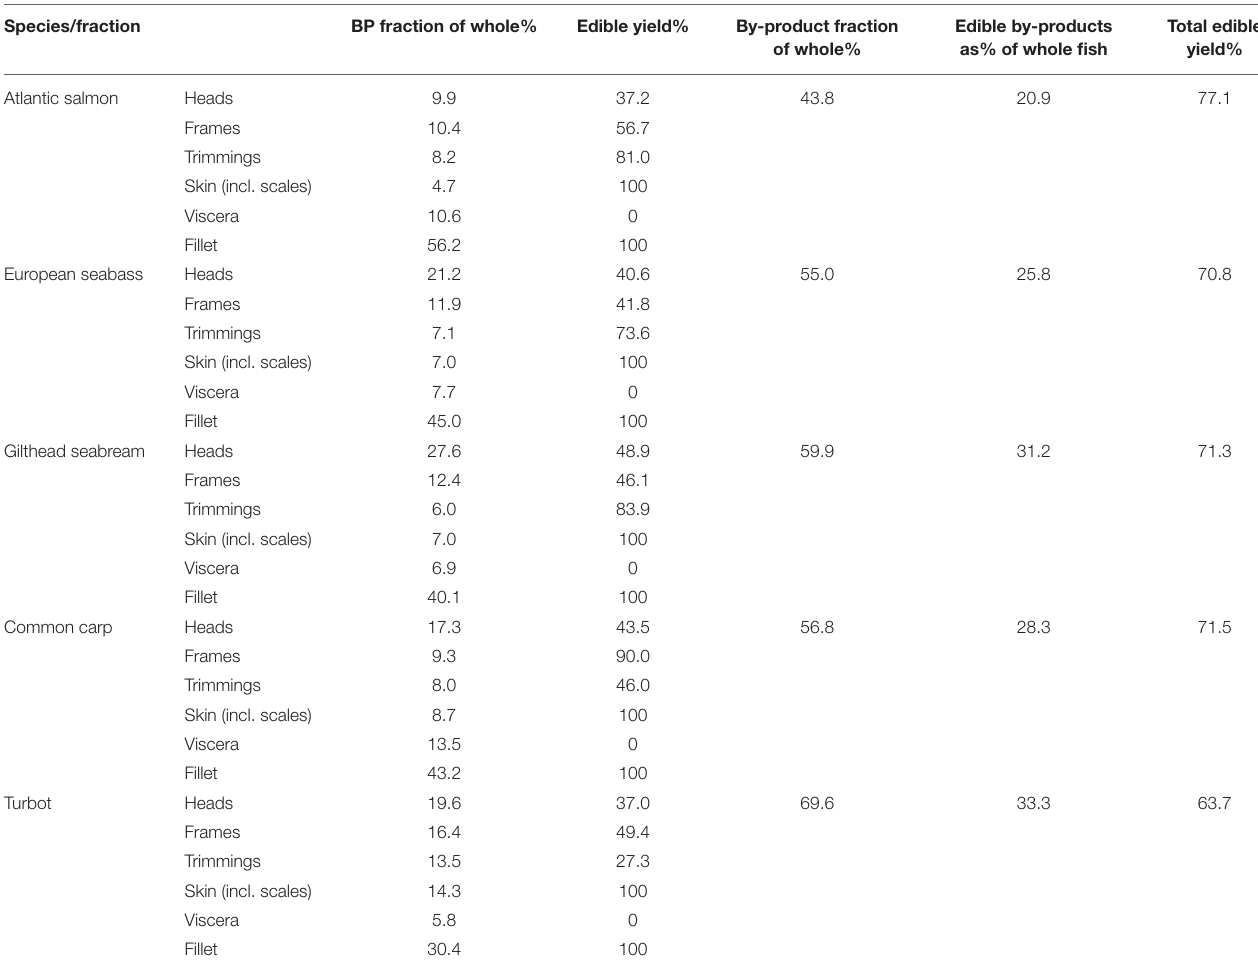
Edible by-products Total edible of whole% as% of whole fish yield%